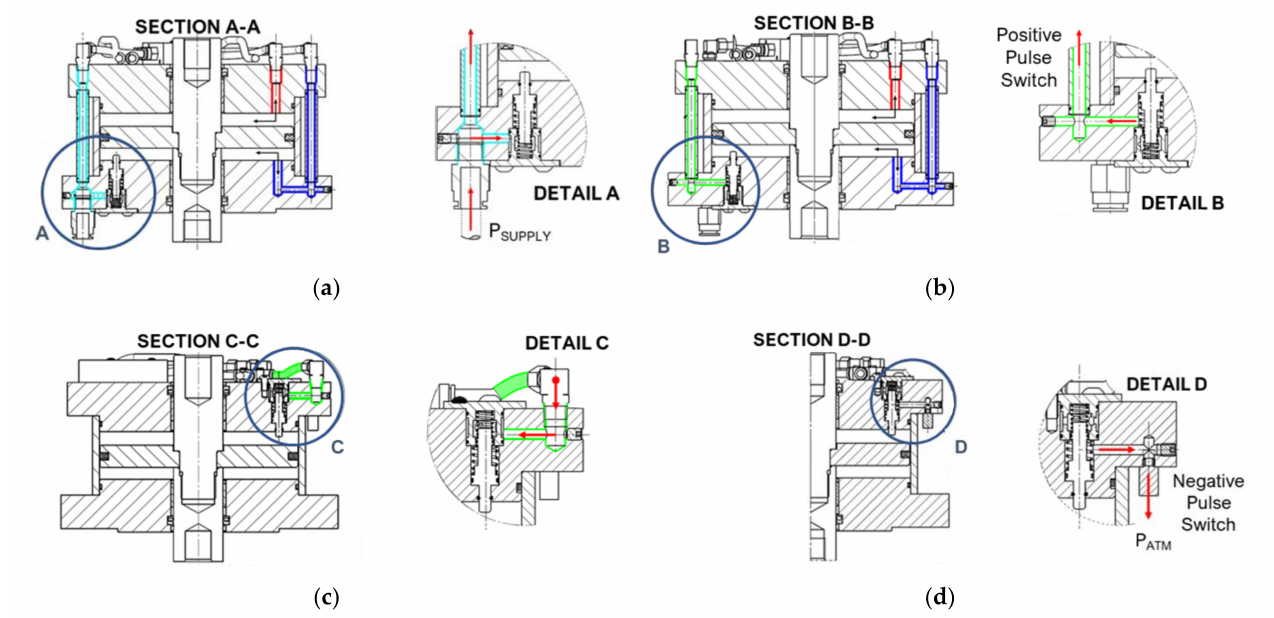
Figure 7. Steps of the working principle of the pneumatic oscillator: ( a ) at a generic instant, the oscillator is powered; ( b ) the inner limit switch is activated; ( c ) the pulse switch of the inner limit switch reaches chamber A of the outer limit switch; ( d ) the outer limit switch is activated. For the sake of clearness, the piston was represented at the same position and both limit switches were represented at the normal position.